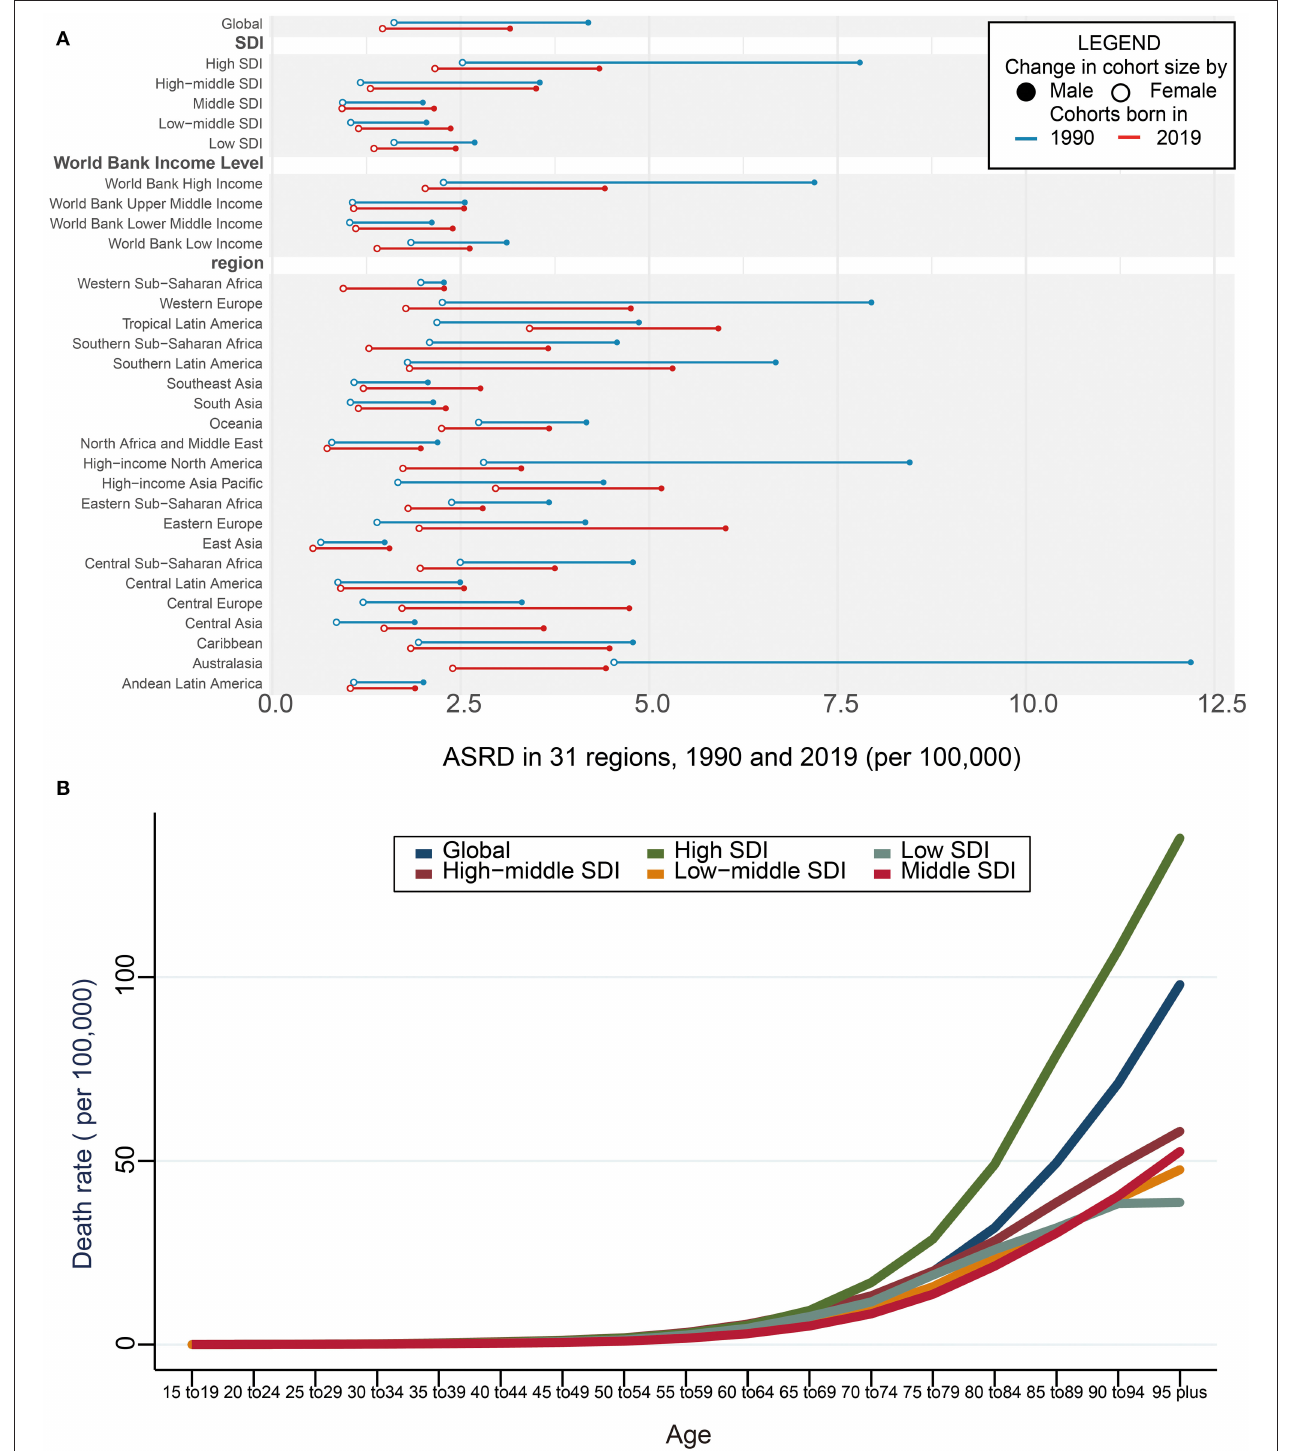
FIGURE 1 | Death and ASRD of aortic aneurysm. (A) Global ASRD with 31 regions from 1990 to 2019. The blue line represents differences in ASRD of men and women in 1990 and the red line represents 2019 year. The black solid circle indicates the male group and the hollow circle the female group. (B) Global ASRD stratified by age and SDI with 5 SDI regions in 2019. SDI, sociodemographic index; ASRD, age-standardized death rate.